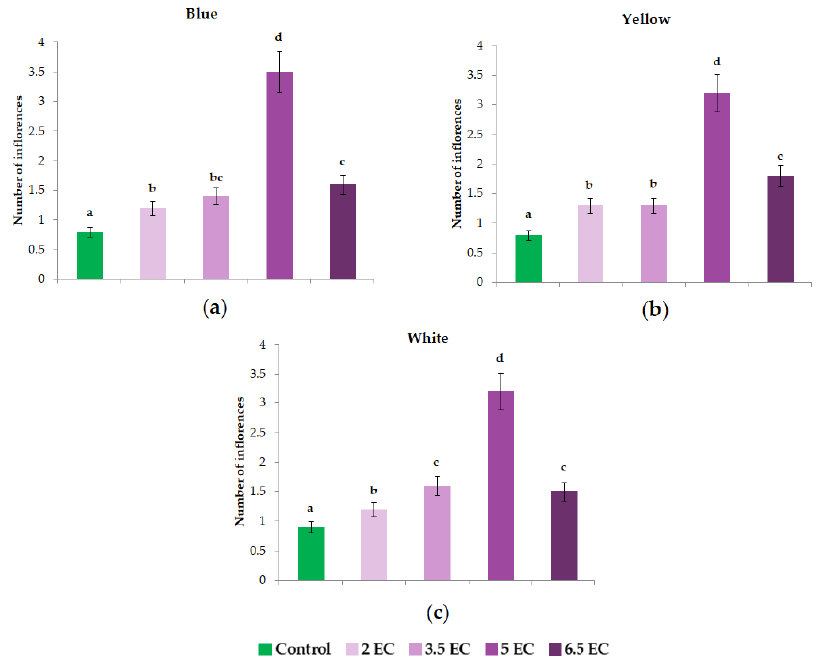
Figure 3. Effect of nutrient solution electrical conductivity levels 1 (control), 2, 3.5, 5, and 6.5 mS cm − 1 EC on the inflorescences number of the selected Viola × wittrockiana seedlings: ( a )—Blue, ( b )—Yellow, and ( c )—White. Bars represent the means ± SE ( n = 40). Different letters indicate significant differences between treatments ( p < 0.05).